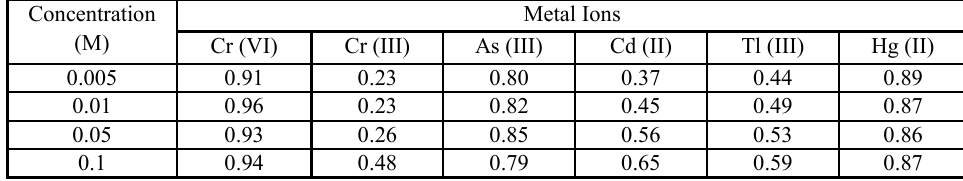
values of metal f